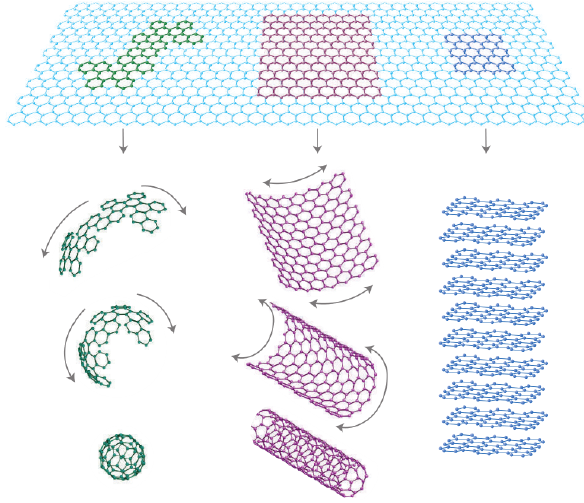
Figure 1: Different forms of graphene [12]